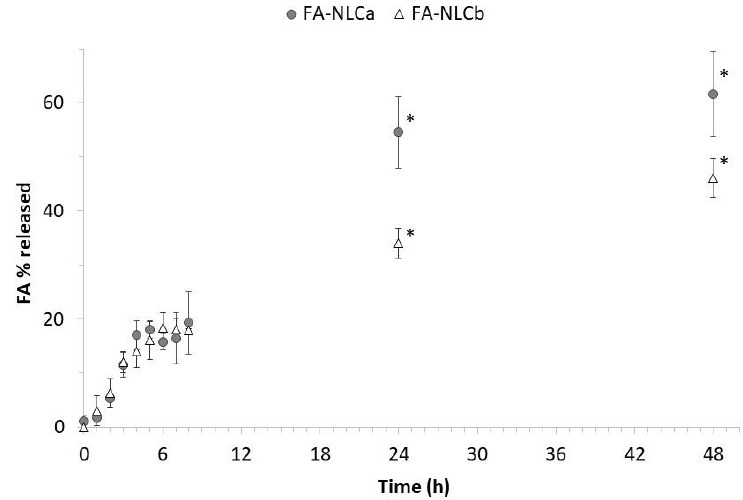
Figure 4. Percentage of ferulic acid (FA) released at different time intervals up to 48 h, from NLC prepared using IPM (FA-NLCa) or Lavandula EO (FA-NLCb) as oily phase. Each value is the mean of six independent experiments. * Significance for p < 0.05.